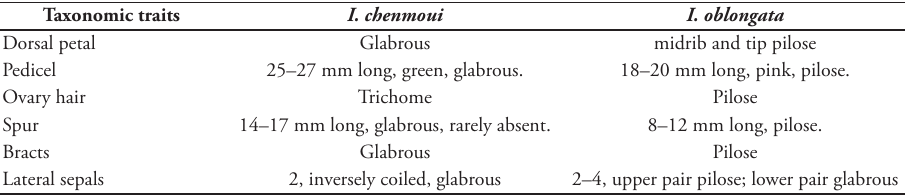
Table 1. Comparison of key features of I. chenmoui and I. oblongata